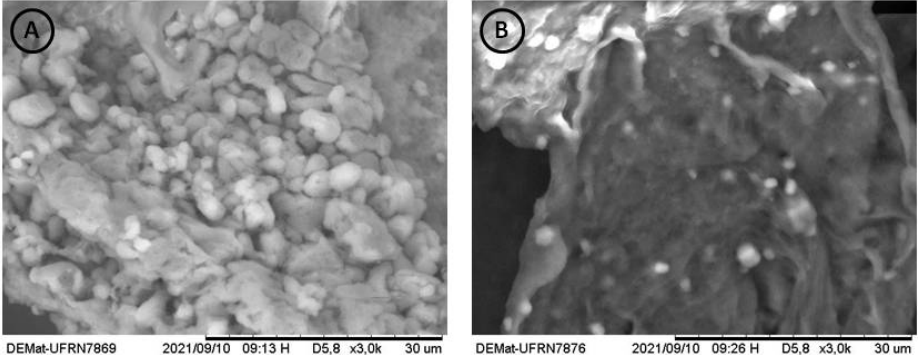
Figure 5. Microbiological biopolymers from R. arrizhus URM 8111—SEM electromicrographies of ( A ) Chit-F at 3000× magnification, ( B ) Chit-FGal at 3000× magnification. The measurement bar = 30 µ m. Each short section corresponds to 3 μ m.